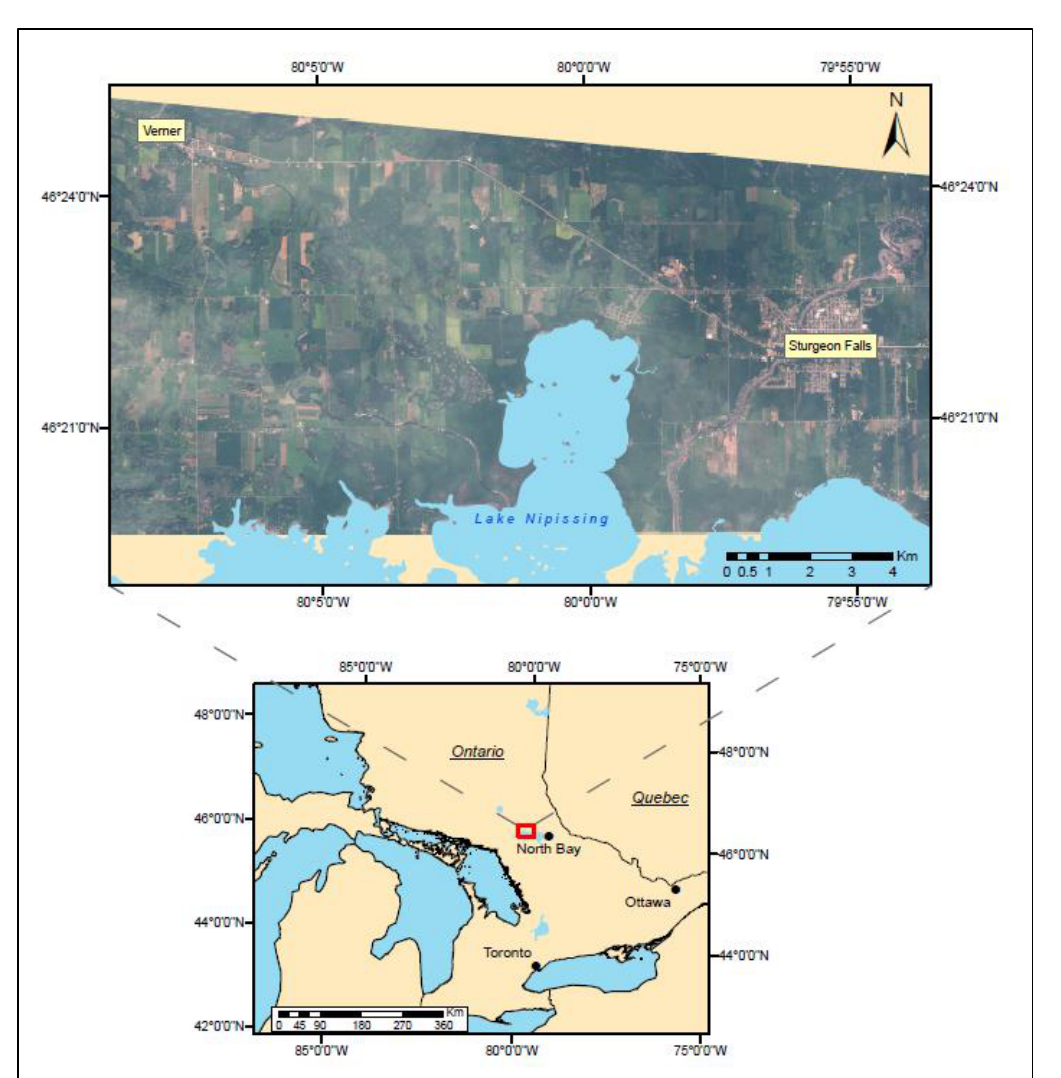
Figure 1. Study location within the municipality of West Nipissing, Ontario displayed on a WorldView-2 image acquired on 2 July